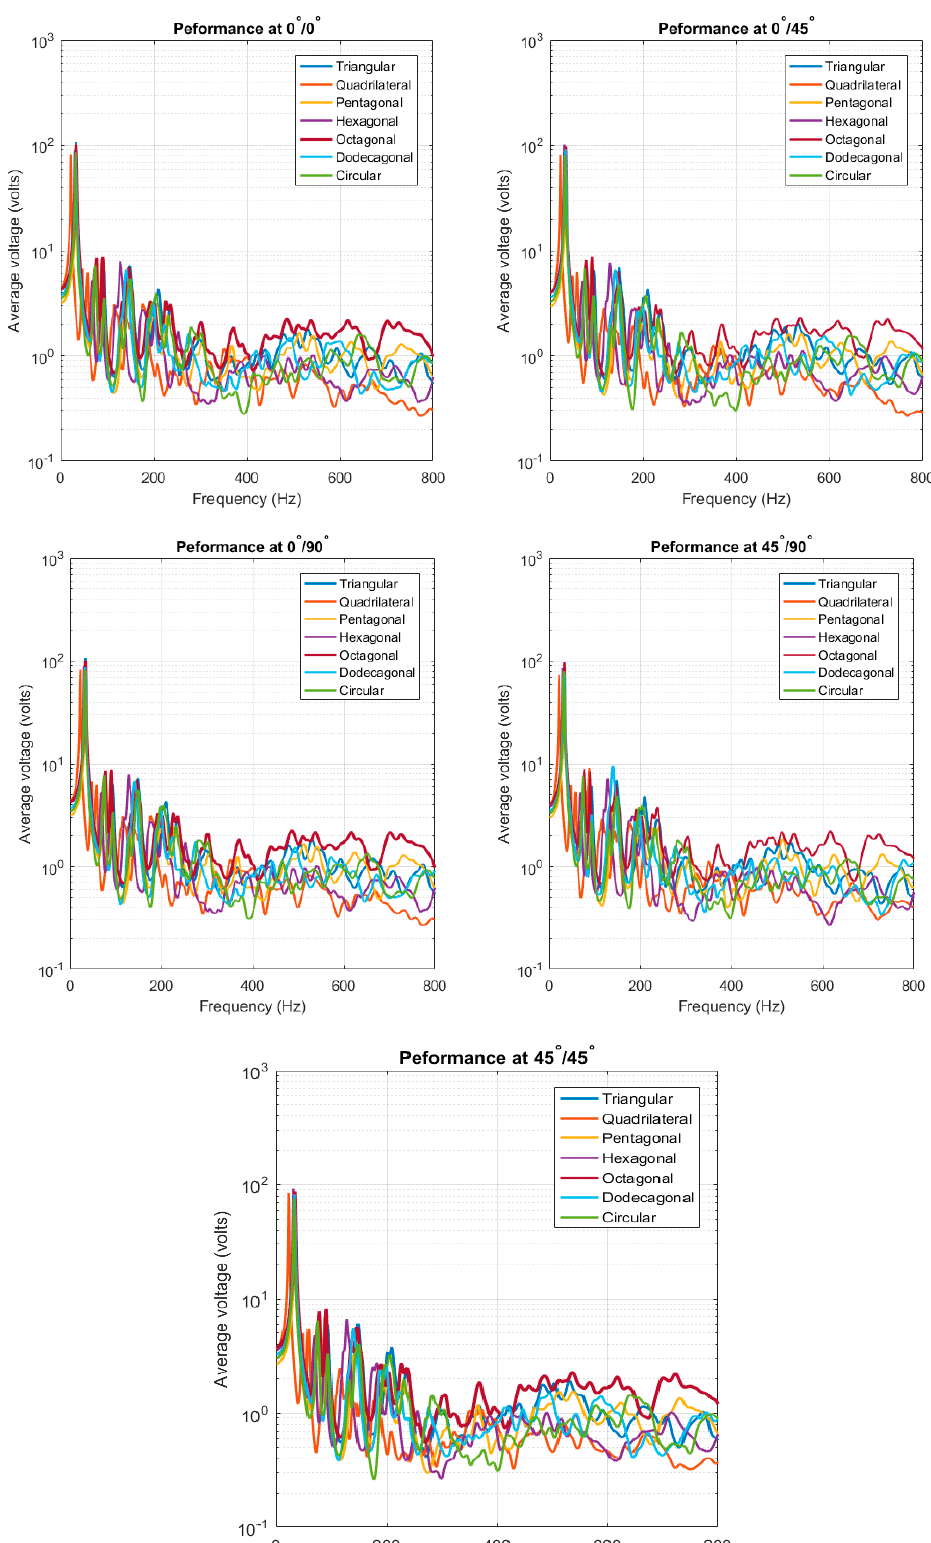
Figure 11. Compiled average-response for double-lamina.